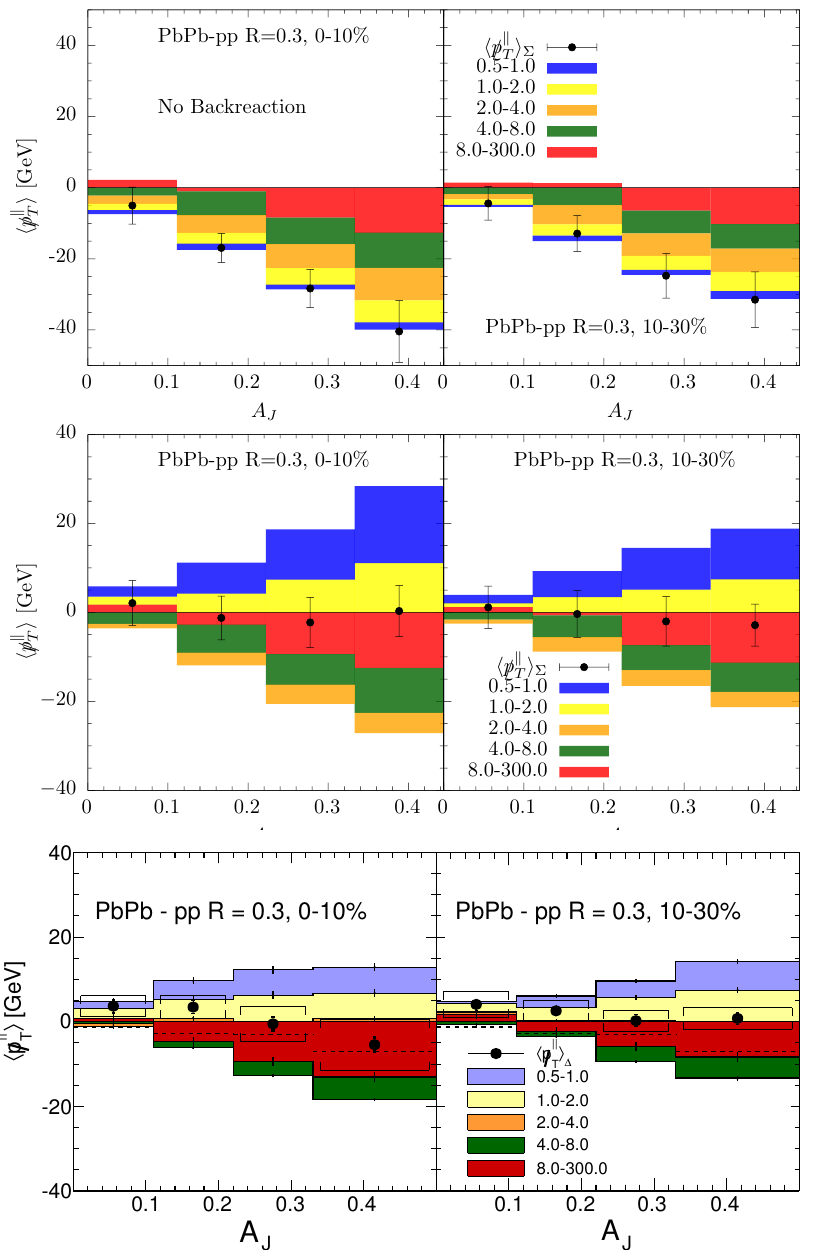
Figure 13 . The middle two panels show the results of our full calculation, while the upper two panels show the results from our hybrid model for energy loss with the contribution from the backreaction of the medium left out. Black points with error bars show the di(cid:11)erence between the missing = p k in PbPb and pp collisions, integrated over all (cid:1), summed over all track momenta, T binned in the dijet asymmetry A J , for events containing R = 0 : 3 dijets in collisions with 0-10% (left) and 10-30% (right) centrality. The colored histograms show the missing = p k momenta is in the indicated range. The lower two panels, obtained from ref. [60], show the results from the same analysis performed on experimental data by the CMS collaboration.